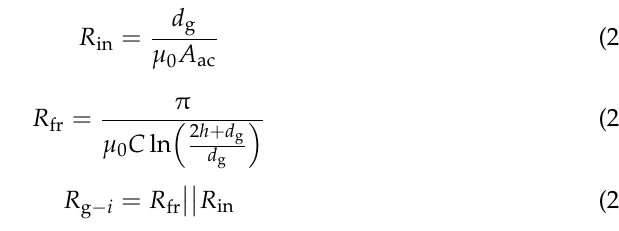
Figure 11. Simplified model of the air gap.